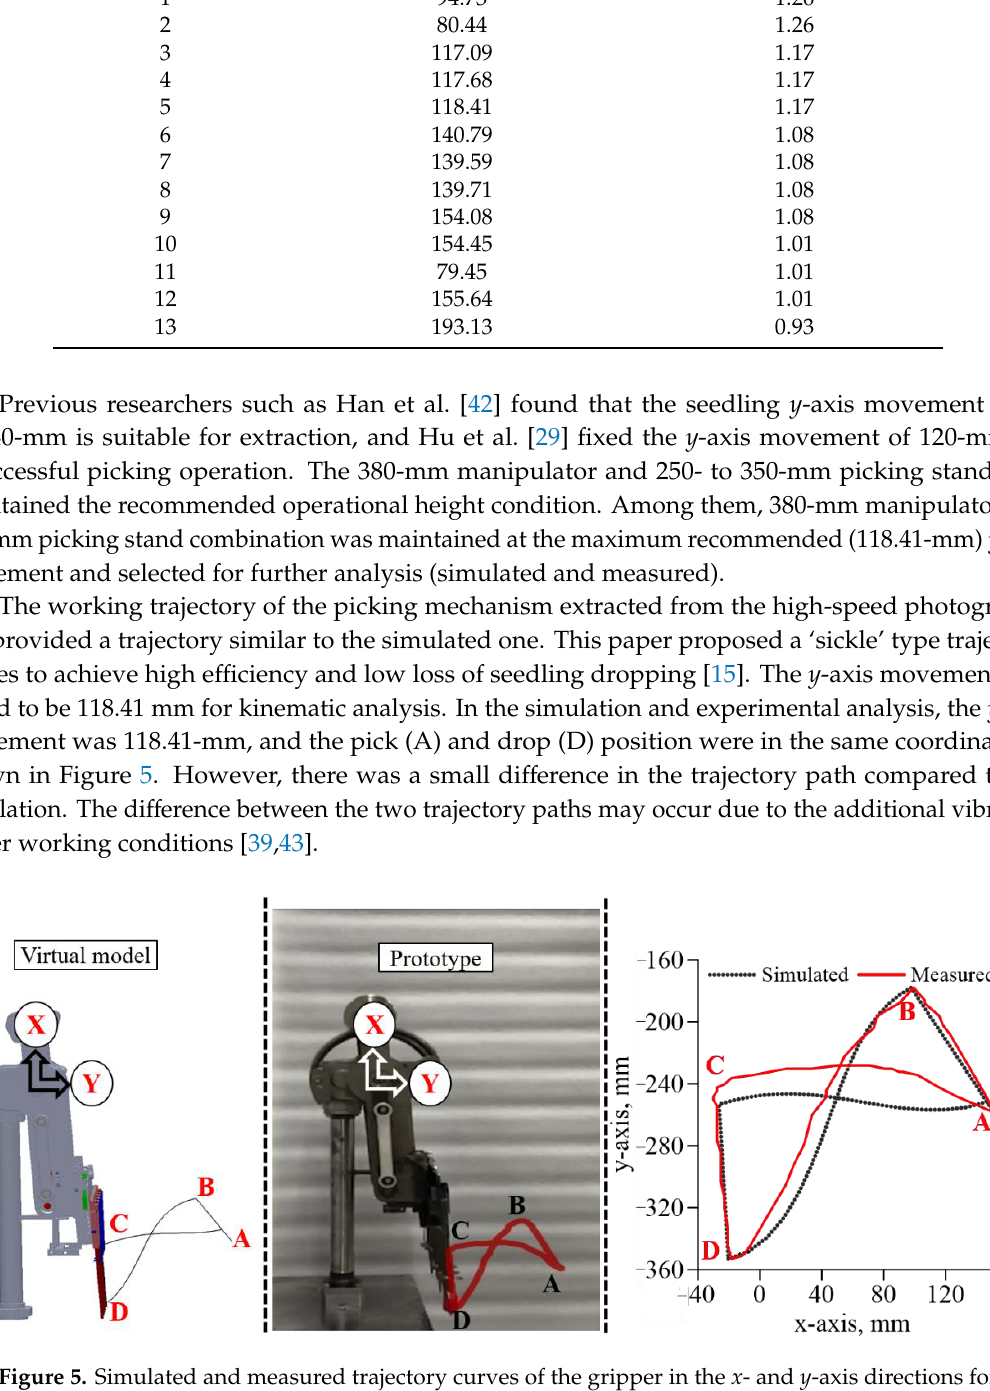
Figure 5. Simulated and measured trajectory curves of the gripper in the x - and y -axis directions for one complete picking cycle.